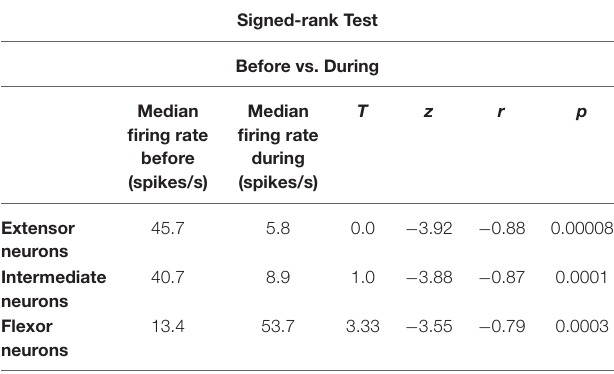
TABLE 1 | We performed the Signed-Rank test to compare the median of the firing rate before and during scratching episodes. Signed-rank Test Before vs. During